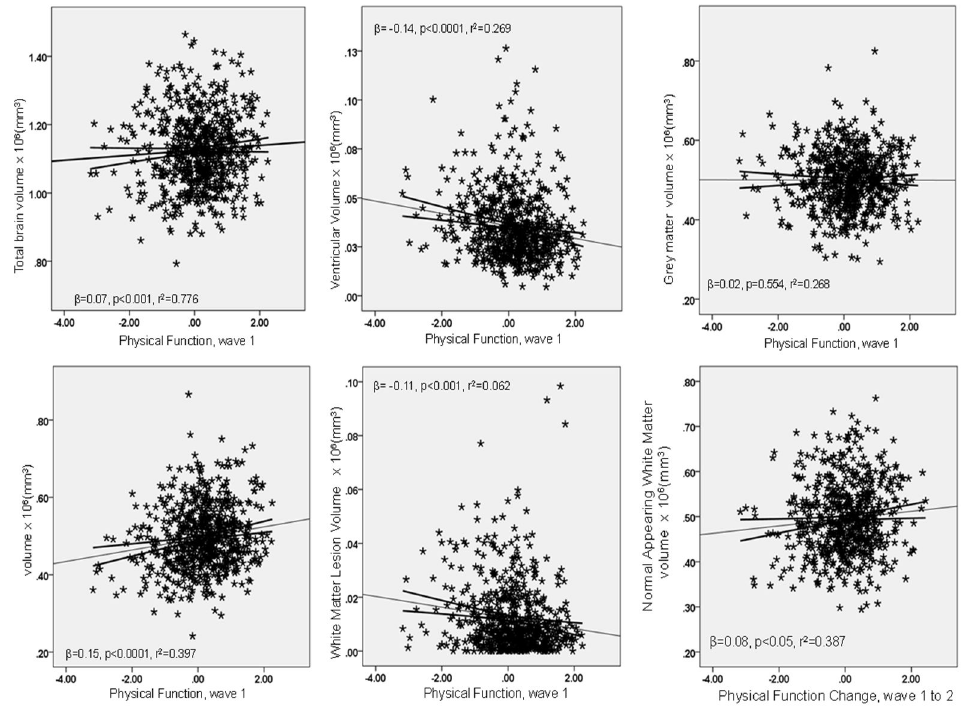
Figure 1. Scatterplots of physical function against brain volumetric parameters. Note. The scatterplots are from the final models accounting for all listed covariates, with the regression line and 95% C.I. displayed. The β and p-value are for the physical function measure, while the R 2 is for the overall model. The final scatterplot shows the association between change in physical function and NAWM volume (the only significant association with change in physical function), and for clarity of illustration, extreme outliers were removed; the inclusion/exclusion of outliers did not alter the regression results. Scatterplots for the Wave 2 physical function measures were similar and are not reported here. See Figures S1-S3 for scatterplots for the individual physical function measures (extreme outliers in the final scatterplots of these figures were retained for illustrative purposes, though their inclusion/ exclusion did not alter the regression